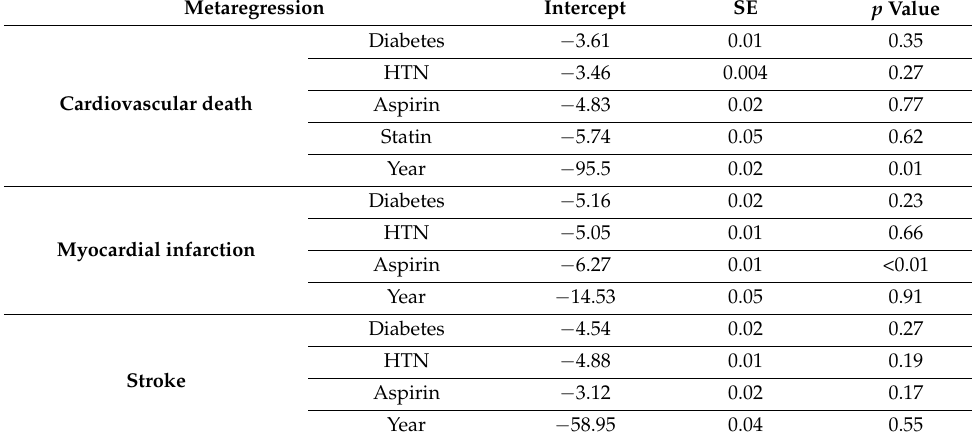
Table 5. Metaregression for MACE and associated risk